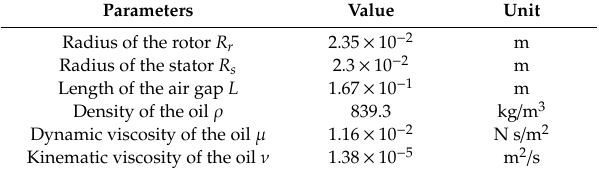
Table 1. The parameters of the electro-hydrostatic actuator (EHA) motor and oil.